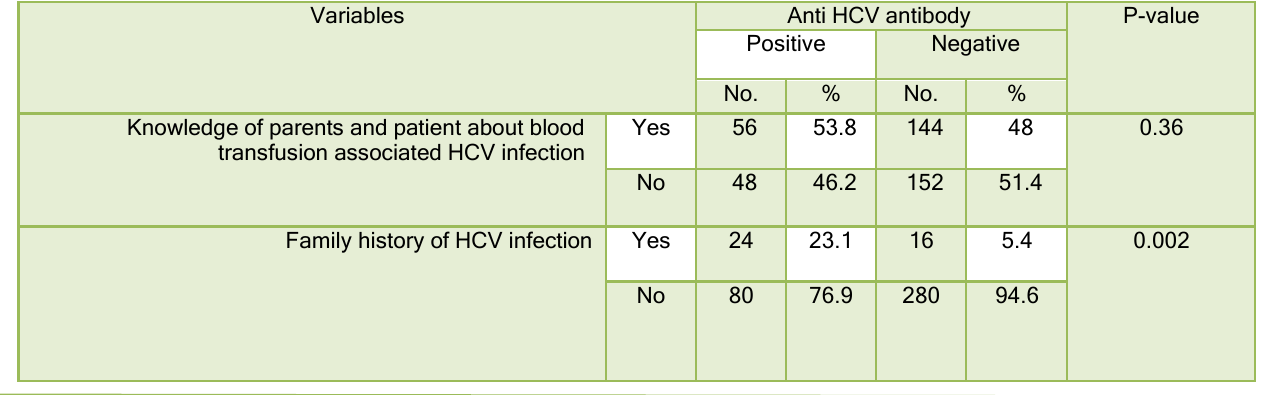
Table 4: The relationship of knowledge of parents and patient about blood transfusion associated HCV infection and family history of HCV with occurrence of